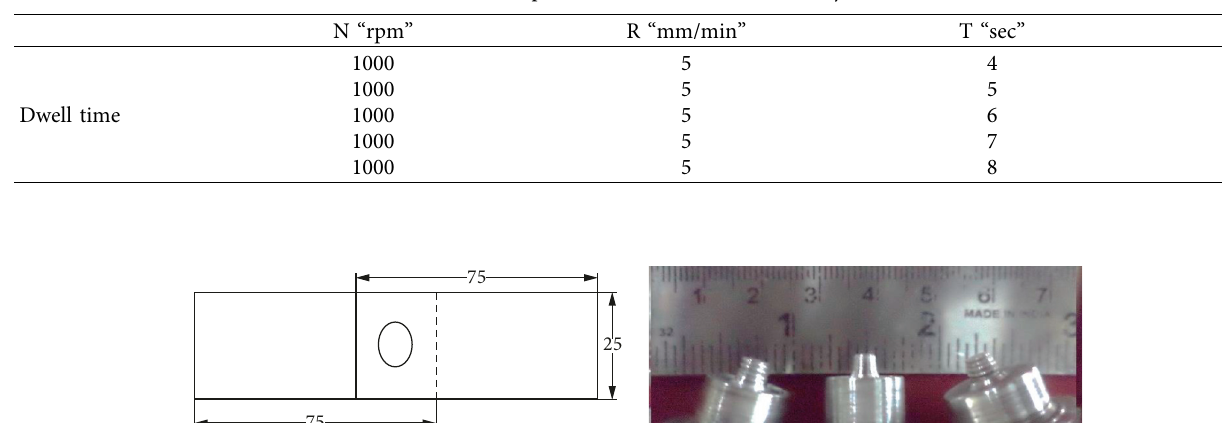
Table 3: FSSW parameters used to fabricate the